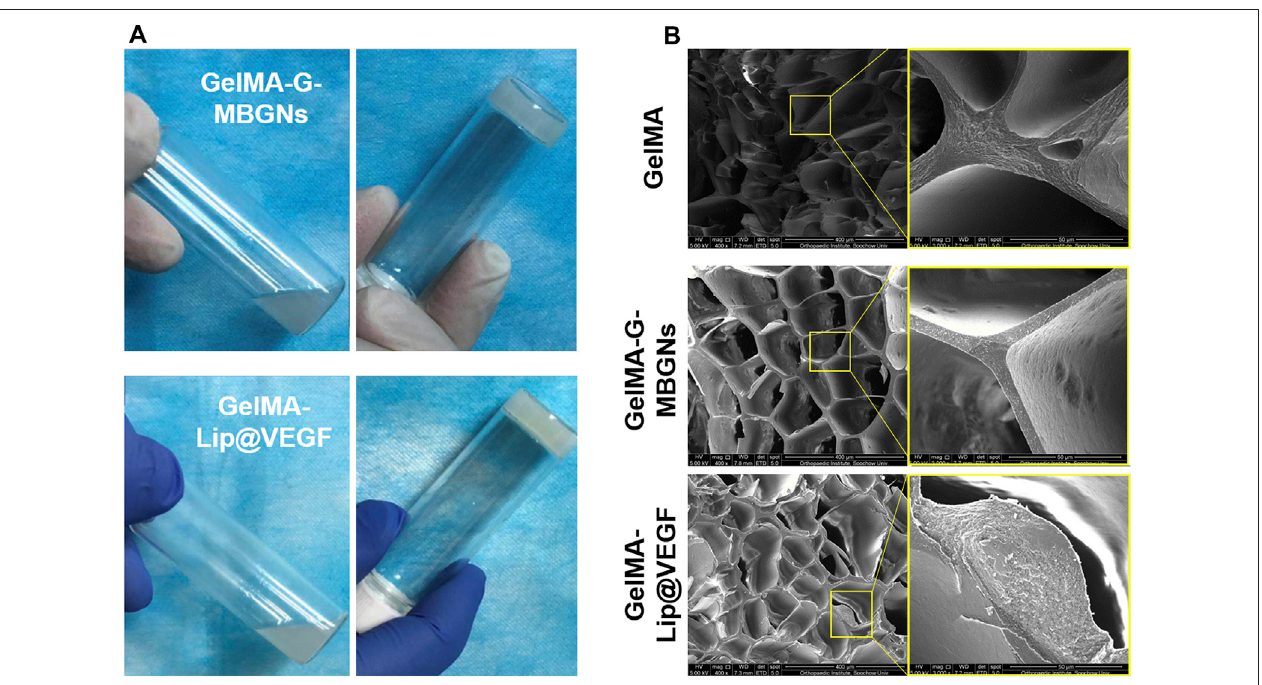
FIGURE3| Characterizationofthegelationprocessandmicrostructure. (A) GelationprocessofGelMA-G-MBGNandGelMA-LipweretriggeredbyUVirradiation. (B) SEM observation of the microstructure.